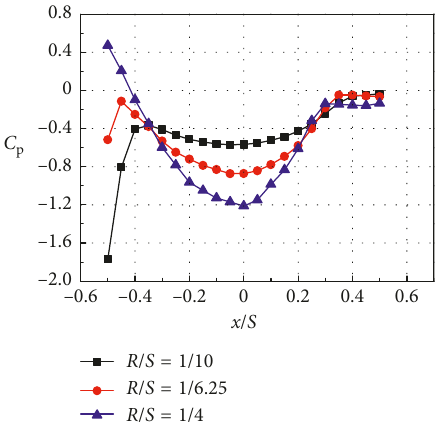
Figure 13: Mean pressure distributions on the middle transverse cross sections of cylindrical roofs with different rise-to-span ratios.